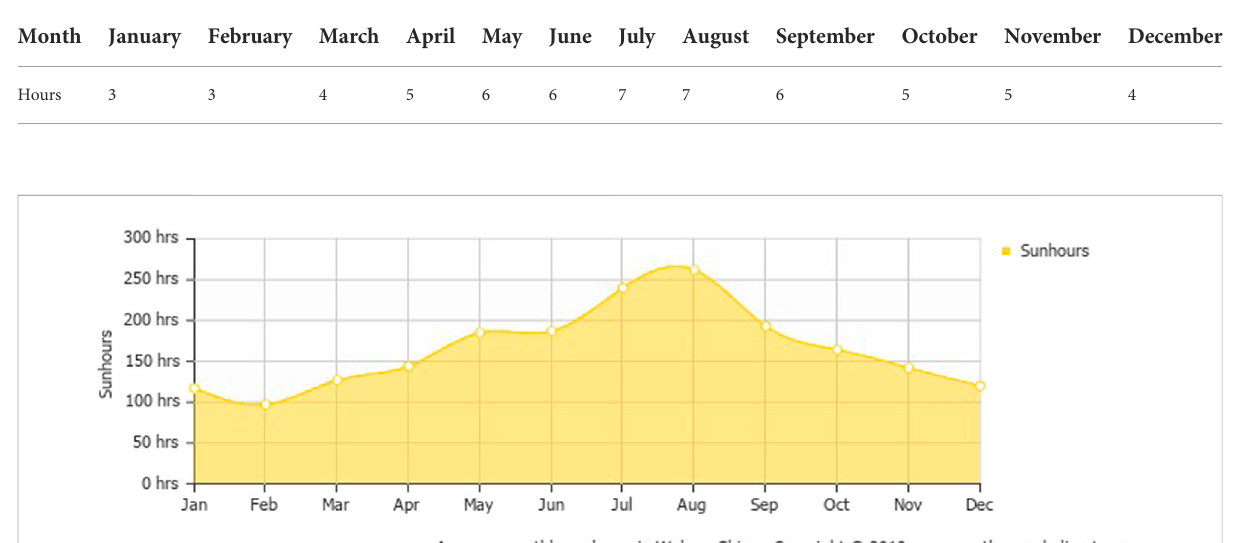
TABLE 2 Average daily sunshine hours in Wuhan City (World Climate Guide, 2020).